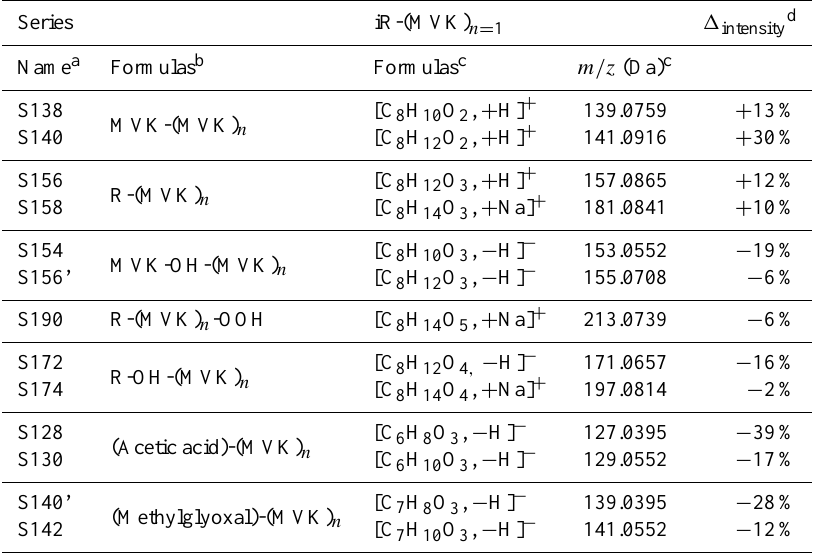
Table 2. Oligomer series identified by UPLC-ESI-MS and ESI-UHRMS in positive and negative